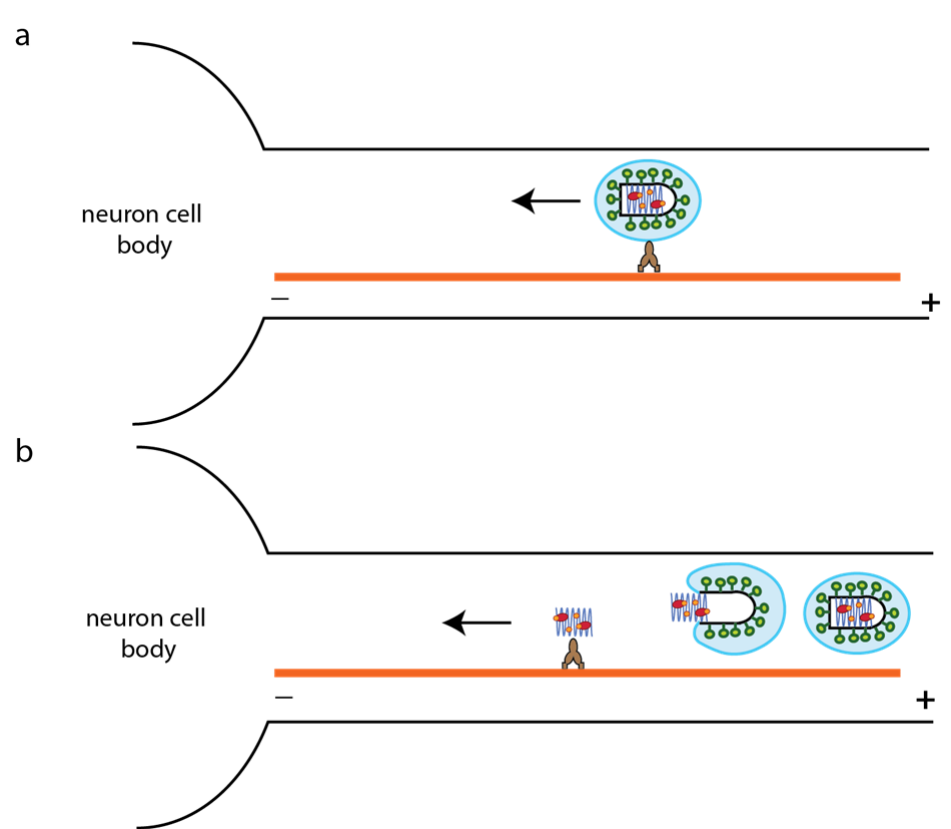
Figure 6. Two plausible pathways for rabies virus (RABV) retrograde transport in the axon. RABV may be transported by two different mechanisms on microtubules either in a vesicle ( a ) or as a free nucleocapsid (after membrane fusion) ( b ). As mentioned in the text, experimental data are in favor of pathway